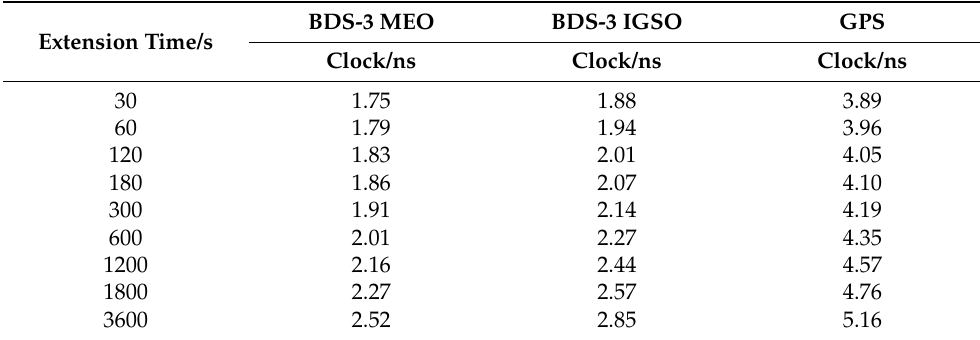
Table 2. Mean RMSE of the PPP-B2b clock products recovered with extension corrections using the GBM clock products as a reference during DOY 192–198 in 2022.